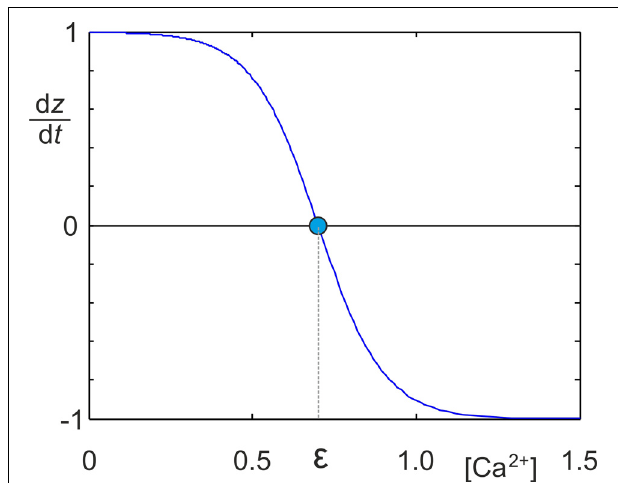
FIGURE 1 | Identical sigmoidal growth rules were used for all types of synaptic elements to determine the change dz / dt in the number of synaptic elements in dependence on the intracellular calcium (cid:3) (cid:2) . z needs to be replaced by the respective type of concentration Ca 2+ element A , D ex or D in . The homeostatic set-point (cid:4) is the value of the calcium concentration where dz / dt =